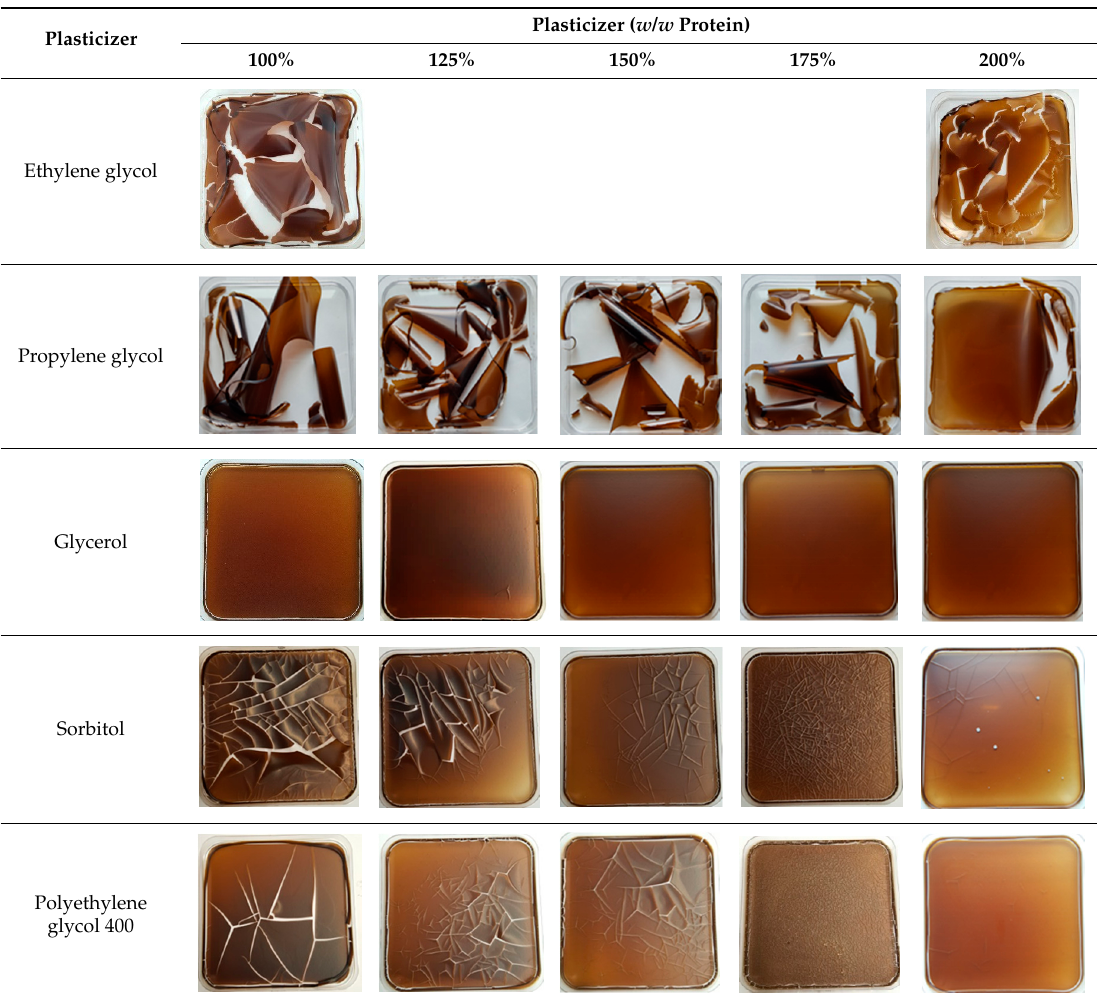
Table 2. Dried cast films with different plasticizers and plasticizer contents from 100% to 200% ( w / w protein) after 21 days at 23 °C and 50% RH. The amount of plasticizer is referred to the pure protein content ( w / w protein).